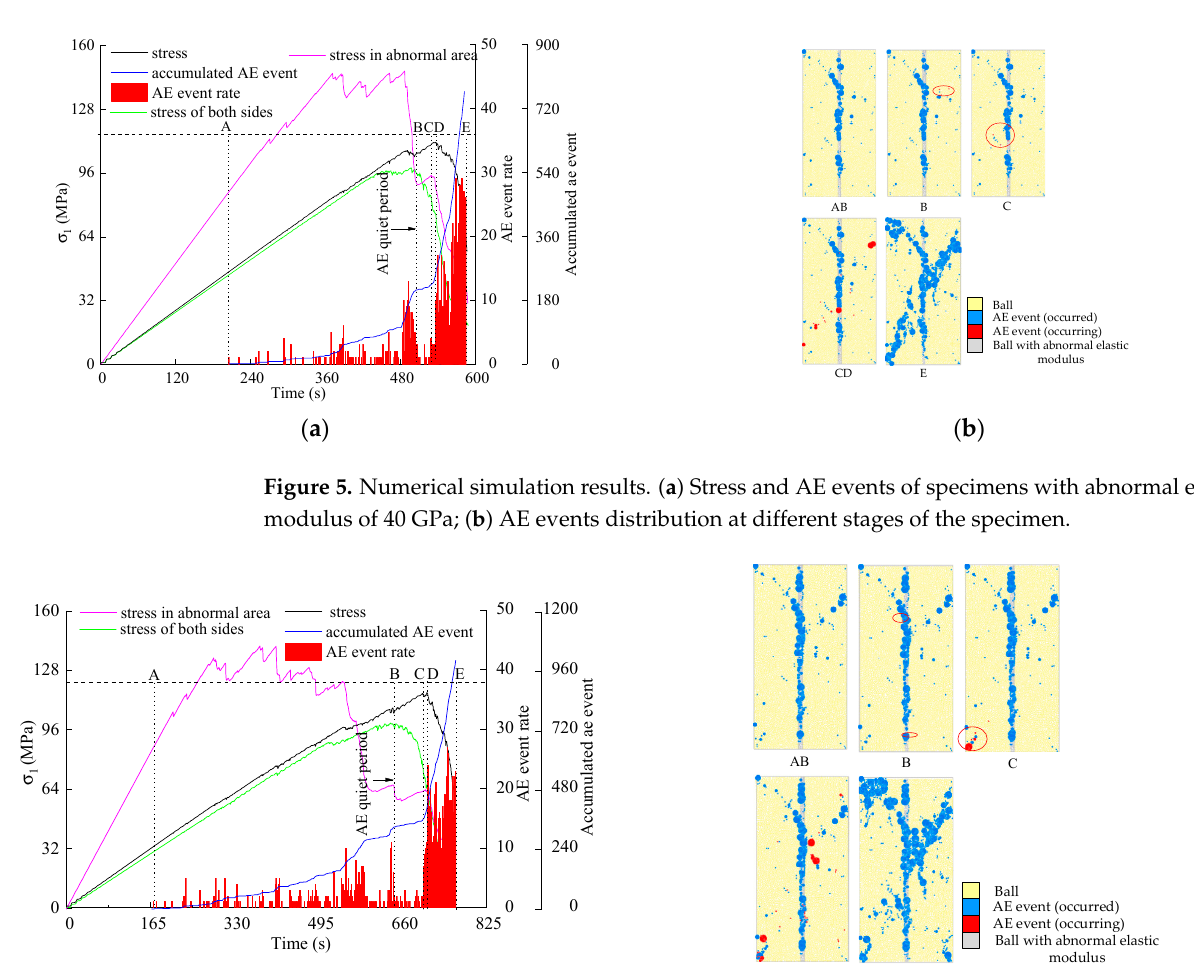
Figure 4. Numerical simulation results. ( a ) Stress and AE events of specimens with homogeneous rock specimens; ( b ) AE events distribution at different stages of the specimen.